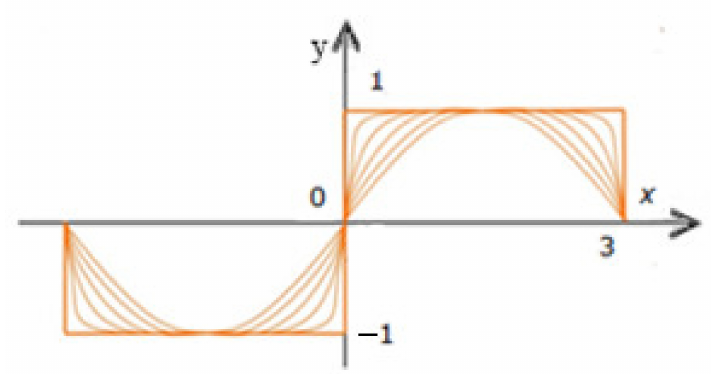
Figure 11. Graphs of the stepped function y = ∑ x with the help of embedded